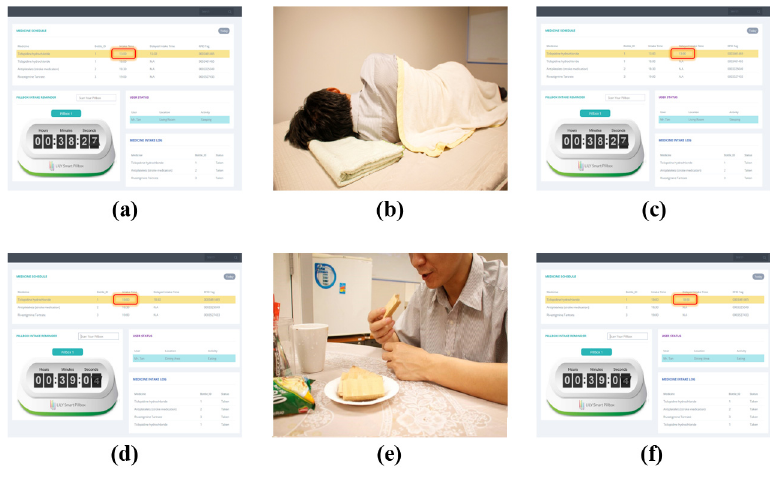
Figure 3. Illustration of